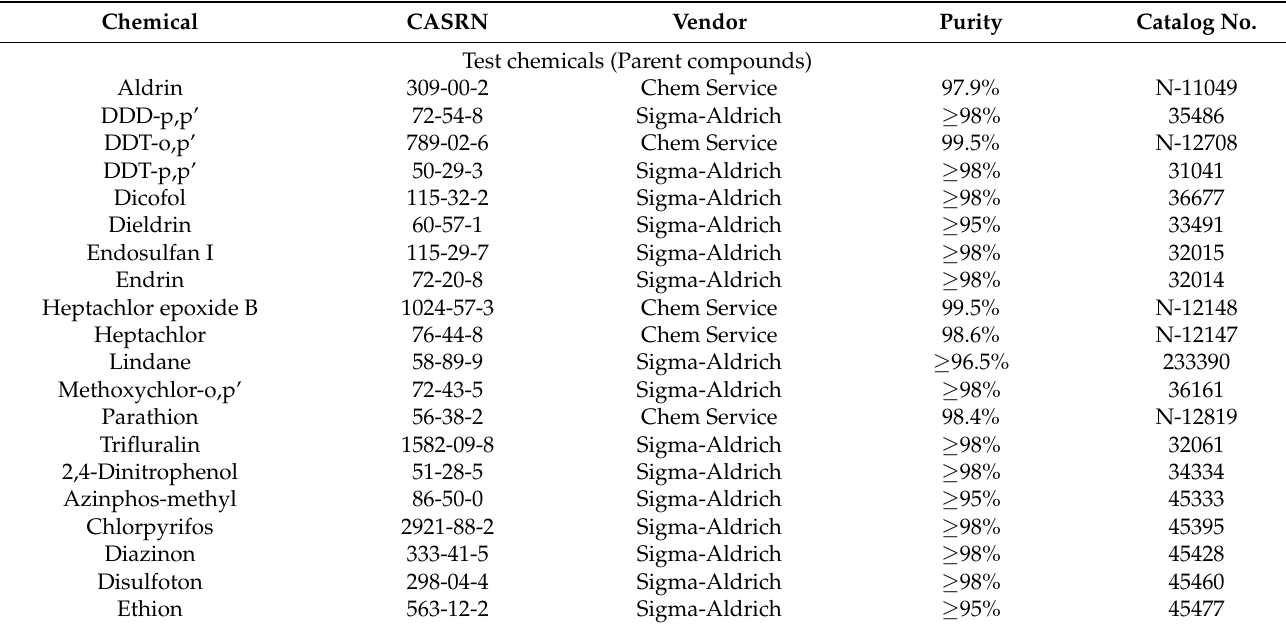
Table 1. Test chemicals and metabolites analyzed in this